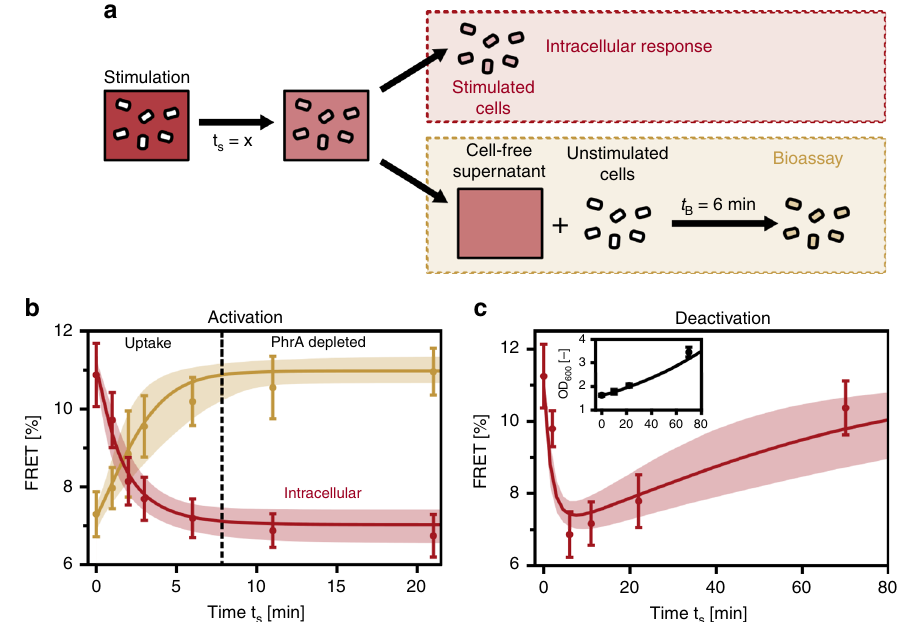
Fig. 4 PhrA activates cells quickly, but cells recover slowly. a Experimental setup used to characterize the signaling dynamics. Cells are exposed to a PhrA stimulus (red color) and take up the signal. Time t s refers to the time between addition of the stimulus and removal of cells from the